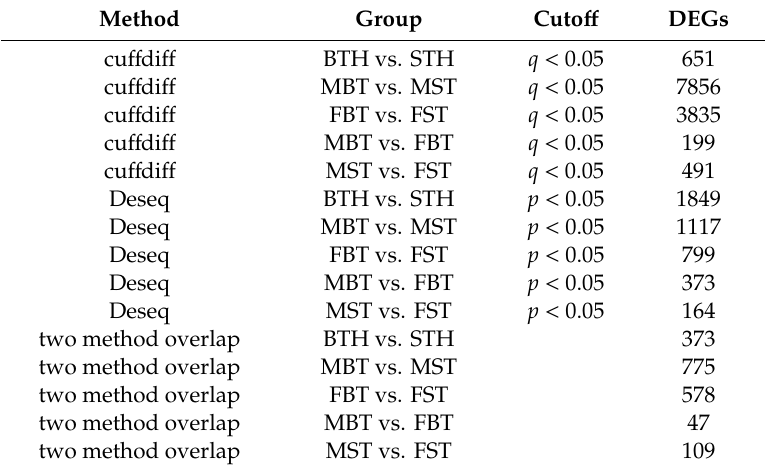
Table 3. Identification of di ff erentially expressed genes by two methods among all